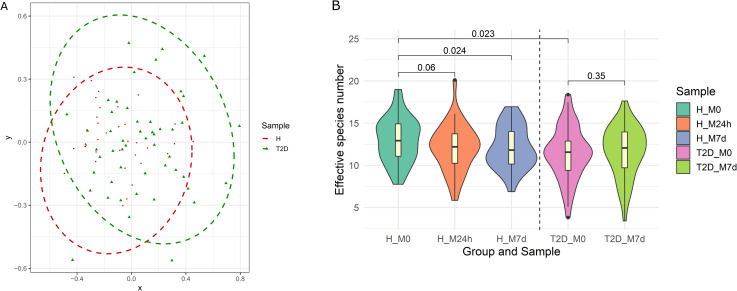
Diversity characteristics of analyzed samples.(A) Beta diversity characterizing and comparing samples before metformin therapy between healthy individuals (H) and OPTIMED cohort patients (T2D). Ellipses represent the 95% confidence interval surrounding each group of samples. Different symbols represent the participants of the study. Red circles correspond to healthy individuals while green triangles represent type 2 diabetes patients. (B) Alpha diversity calculated in all analyzed time points. Groups marked as follows: H–healthy individuals; T2D – type 2 diabetes patients. Samples: M0—before starting metformin treatment; M24h – 24 hours after the first intake of metformin; M7d –after 7 days treatment with metformin. Violin plot representing the effective number of species combines boxplots, depicting the median value and interquartile ranges, with Kernel density plots.